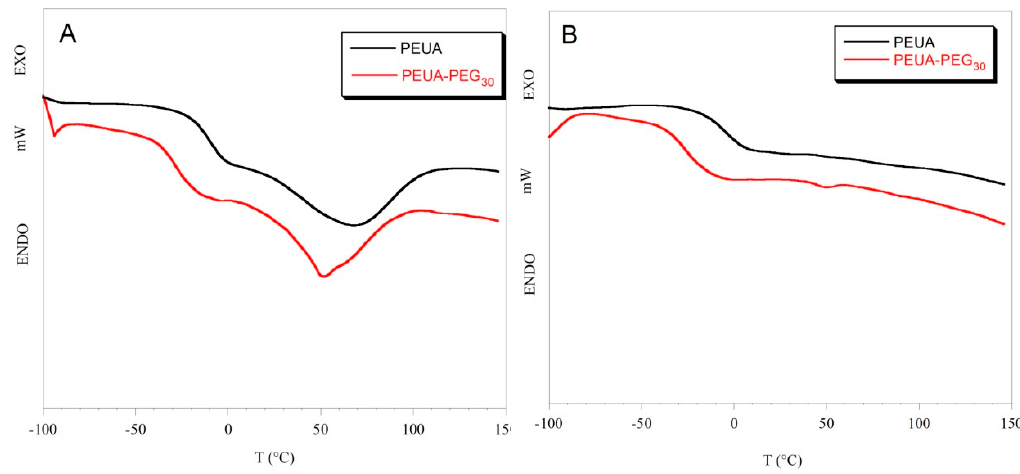
Figure 4. Thermograms of PEUA and PEUA-PEG 30 in the I cycle ( A ) and the II cycle ( B ) of heating.